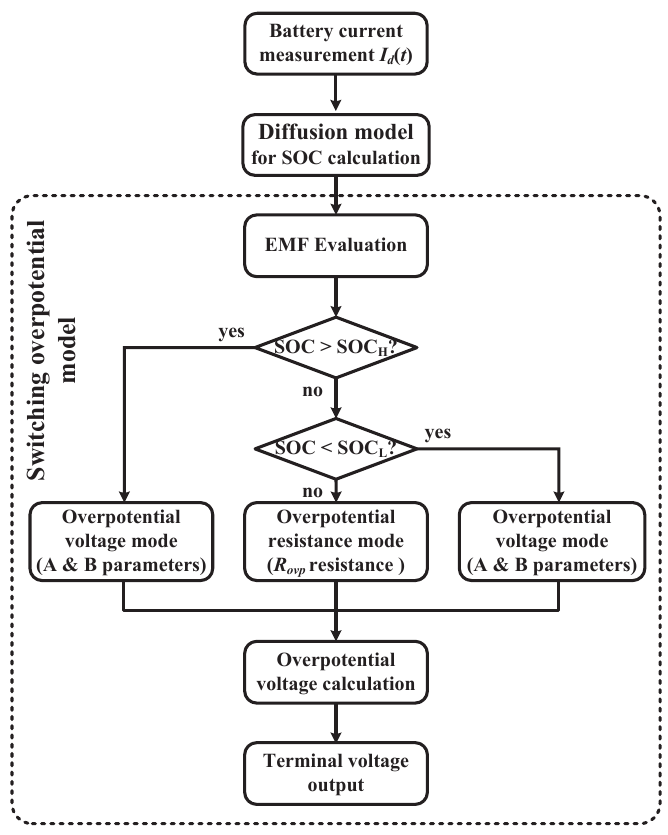
Figure 3. Flowchart of the proposed battery simulator for voltage